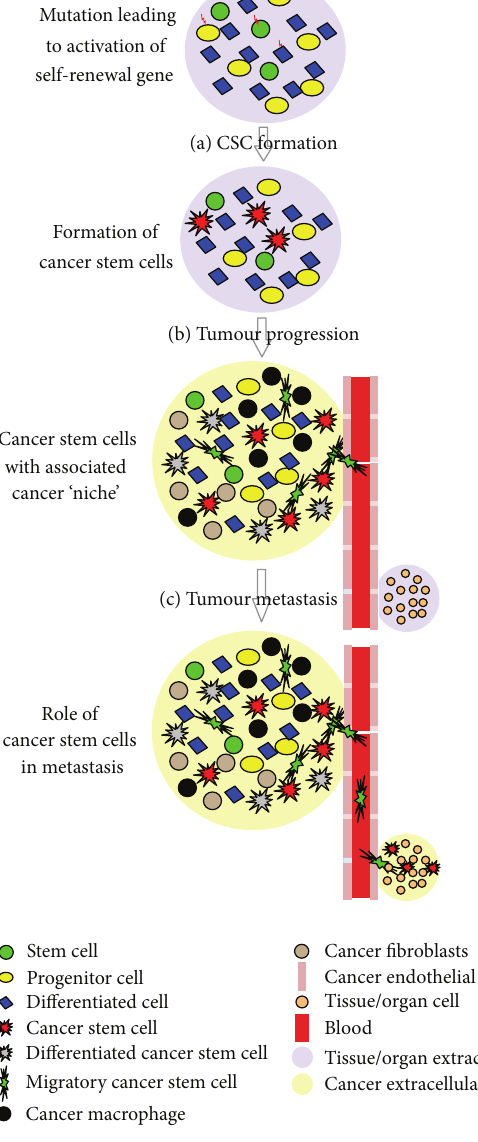
Figure 2: Simplified “Unifying Hypothesis” on origin of CSC, its role in tumor progression and metastasis. (a) CSC formation- mutation in normal stem, progenitor, or differentiated cell will activate self-renewal genes to form CSC. Accumulating evidence suggests the importance of “CSC niche” and its interdependence with CSCs. A “CSC Niche” will consist of plethora of molecules and cellslikestemcells,surroundingdifferentiatedcells,stromalsupport cells, inflammatory cells, soluble factors, extracellular matrix, and blood vessels. (b) Tumor progression—according to “Cancer Stem Cell Hypothesis” CSCs have the capacity to undergo self-renewal and have the potential to differentiate into different types of cells in a specific lineage. This accounts for heterogeneity and progression of tumor. (c) tumor metastasis—specialized stem cells described under the concept of “Migrating cancer stem (MCS)-cells” along with cancer angiogenesis play important role in tumor metastasis. MCS-cells disseminate through various portals like blood vessels to various distant organs/tissues which provide favorable environment for the growth and division of these migrated